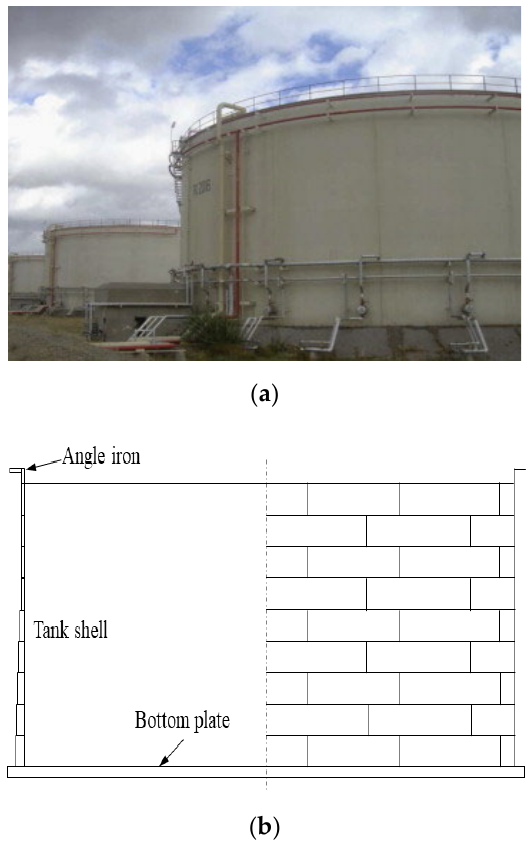
Figure 1. The structure prototype of the steel tank: ( a ) steel tanks in practical engineering [13]; ( b ) illustration of bottom plate and shell